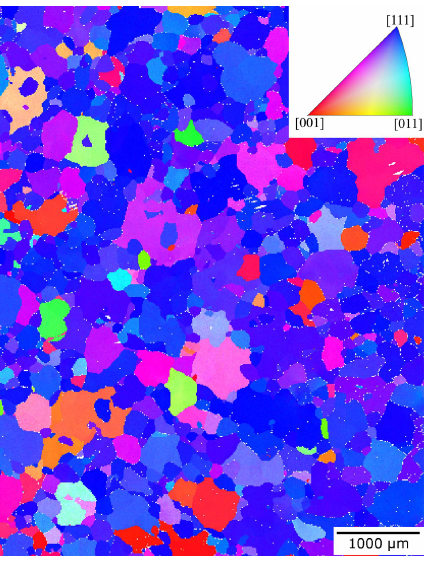
Figure 3 Grain orientations measured using EBSD for DX54 ferritic steel, observed on the xy (RD-TD) plane of the material. IPF- z colouring is shown, where z is equivalent to the normal direction,